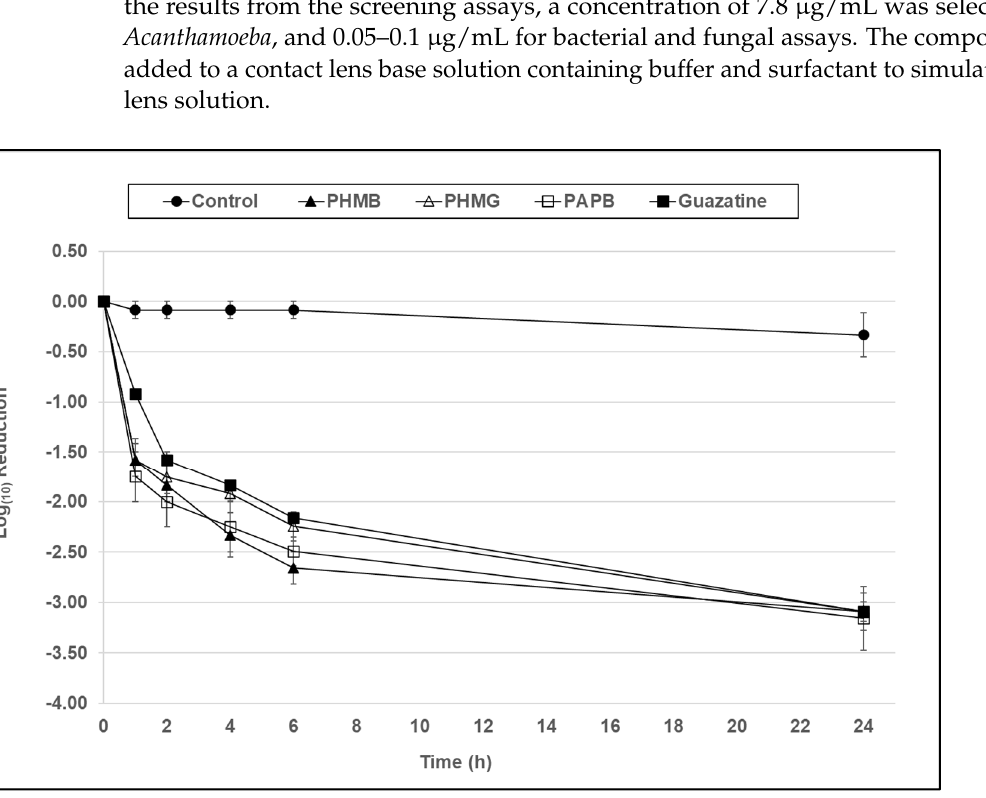
Figure 2. The antimicrobial activity of PHMB, PHMG, PAPB, and guazatine against A. castellanii (ATCC 50370) trophozoites over a 24 h period at a concentration of 7.8 µg/mL formulated in a con- tact lens base solution. Error bars show the standard error of the mean (SEM) from triplicate exper- iments. In Figures 1 and 2, at a concentration of 7.8 µg/mL, all compounds demonstrated antimicrobial activity against trophozoites of both Acanthamoeba species, resulting in a 2–